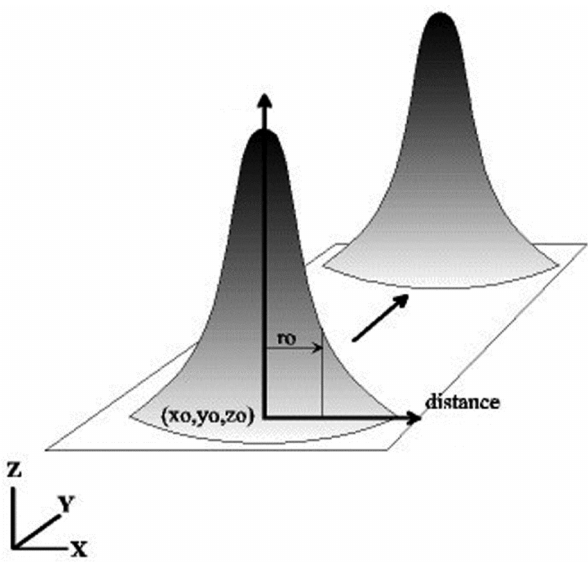
Figure 3: 2D Gaussian heat